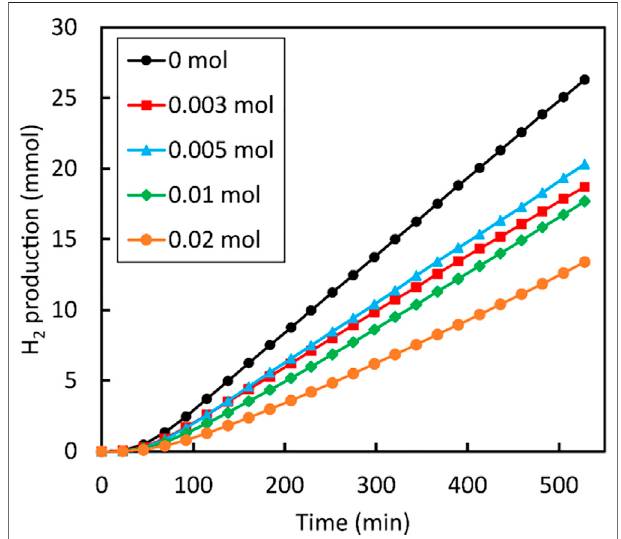
FIGURE 12 | H 2 production by ZnS nanoparticles prepared using different amounts of NaBH 4 .